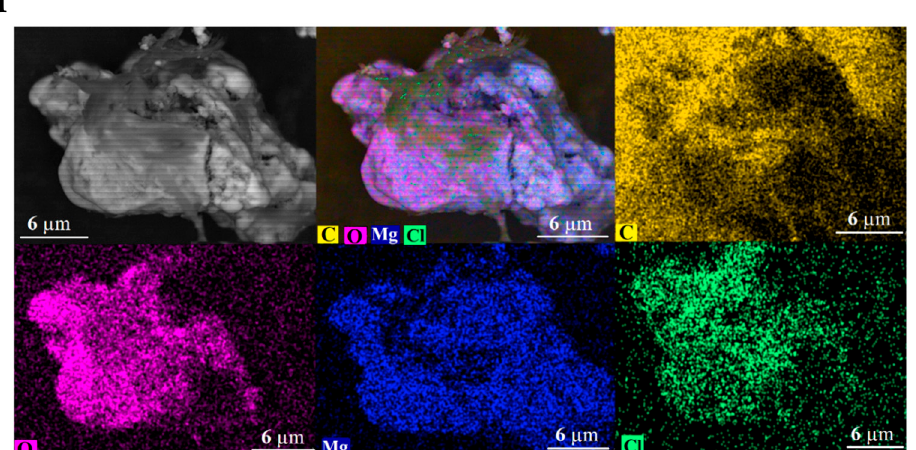
Figure 1. Characteristics of DDM. ( a ) Diagram of DDM synthesis. ( b ) The crystallinity behavior of MgO-NPs, and amorphous shape of organic shells in the synthesized DDM by XRD analysis. ( c ) EDX spectra of the synthesized DDM. ( d ) Elemental mapping images of the synthesized DDM.